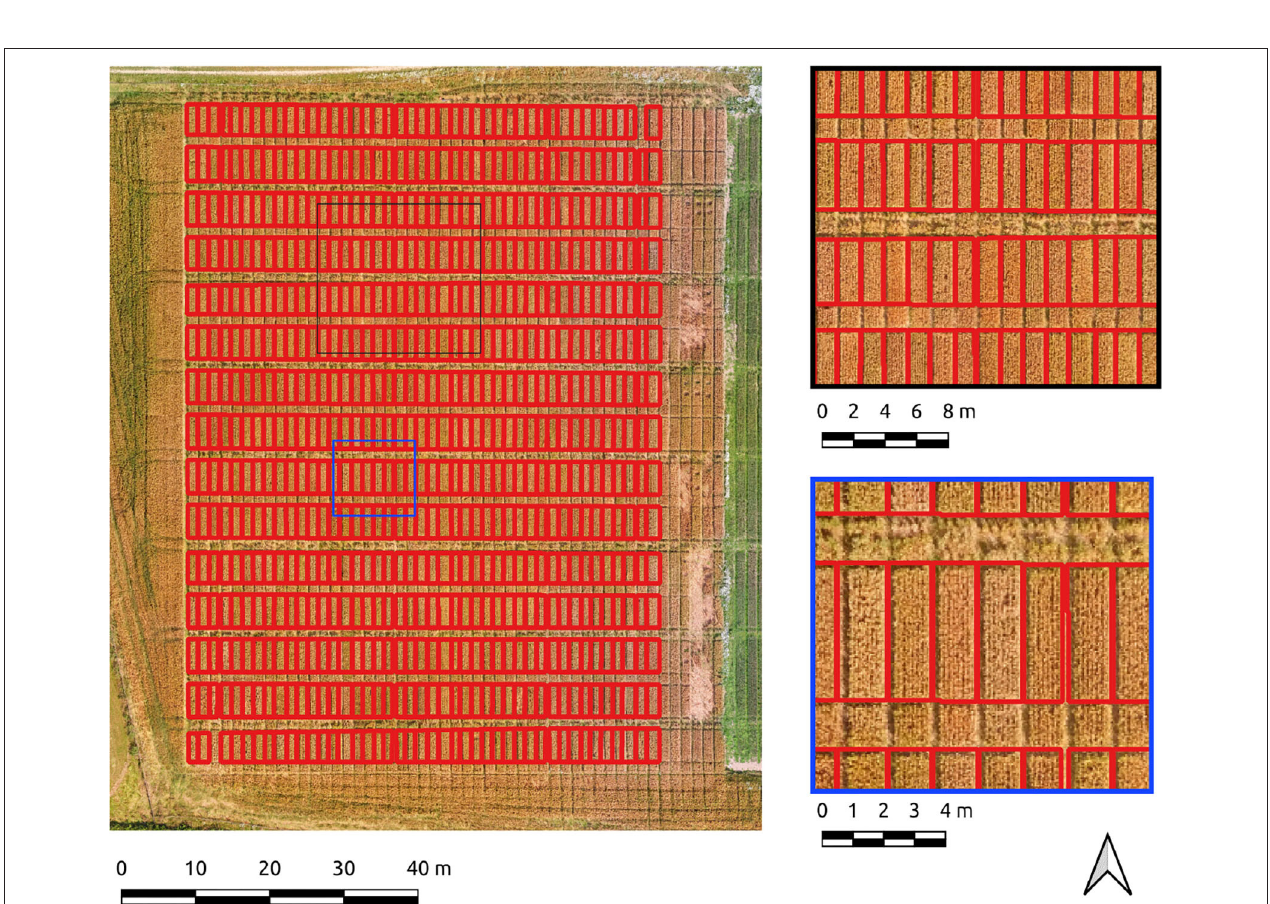
FIGURE 4 | Segmentation results on the Cae Tatws site dataset using Canny edge detection.